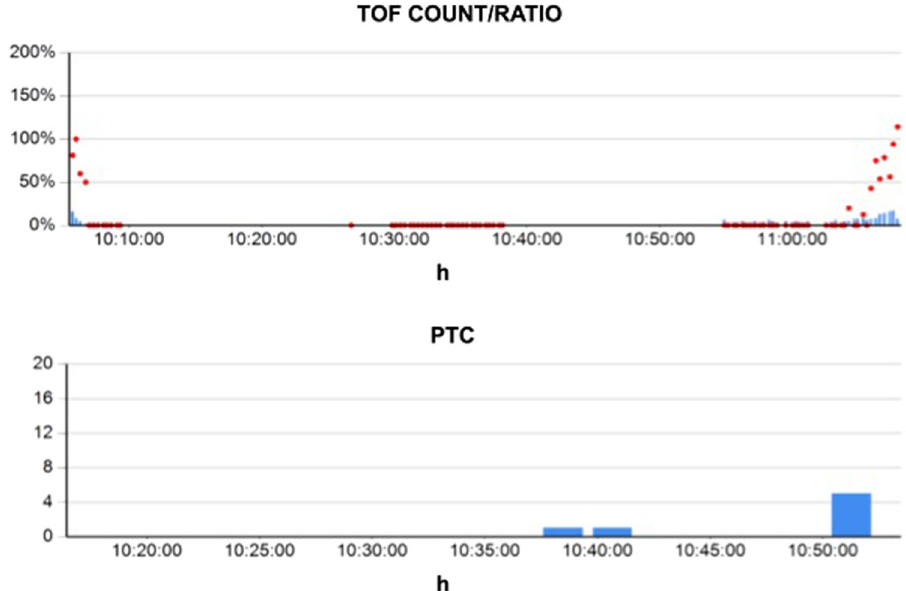
Fig. 5 The i-TOF report. The i-TOF report: an example of a data report created by the I-TOF application on a smartphone during a session. The upper side shows values of TOF count (blue columns) and TOF ratio (red dots). The lower side shows values of PTC; h